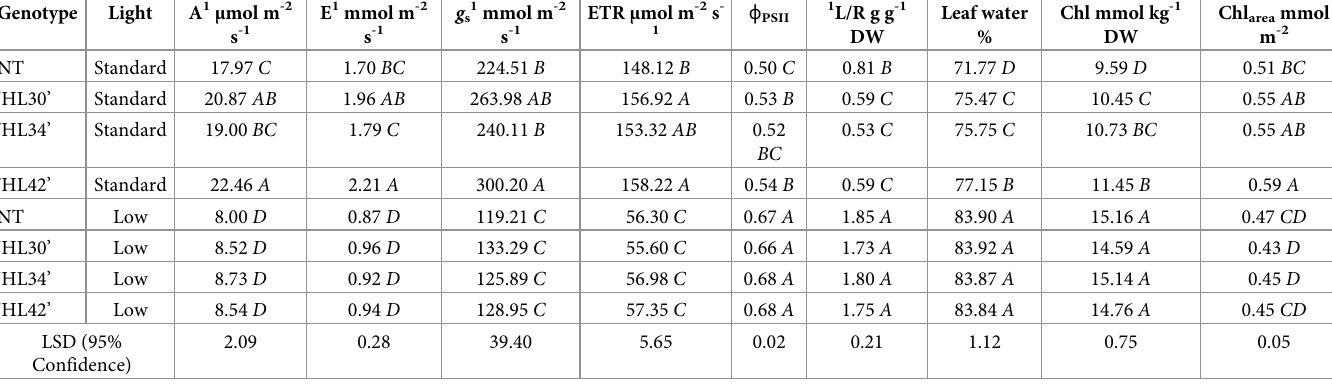
Table 2. Effect of low light on photosynthesis parameters, leaf-to-root ratio, leaf water, and chlorophyll of high lipid Lolium and control. Genotype